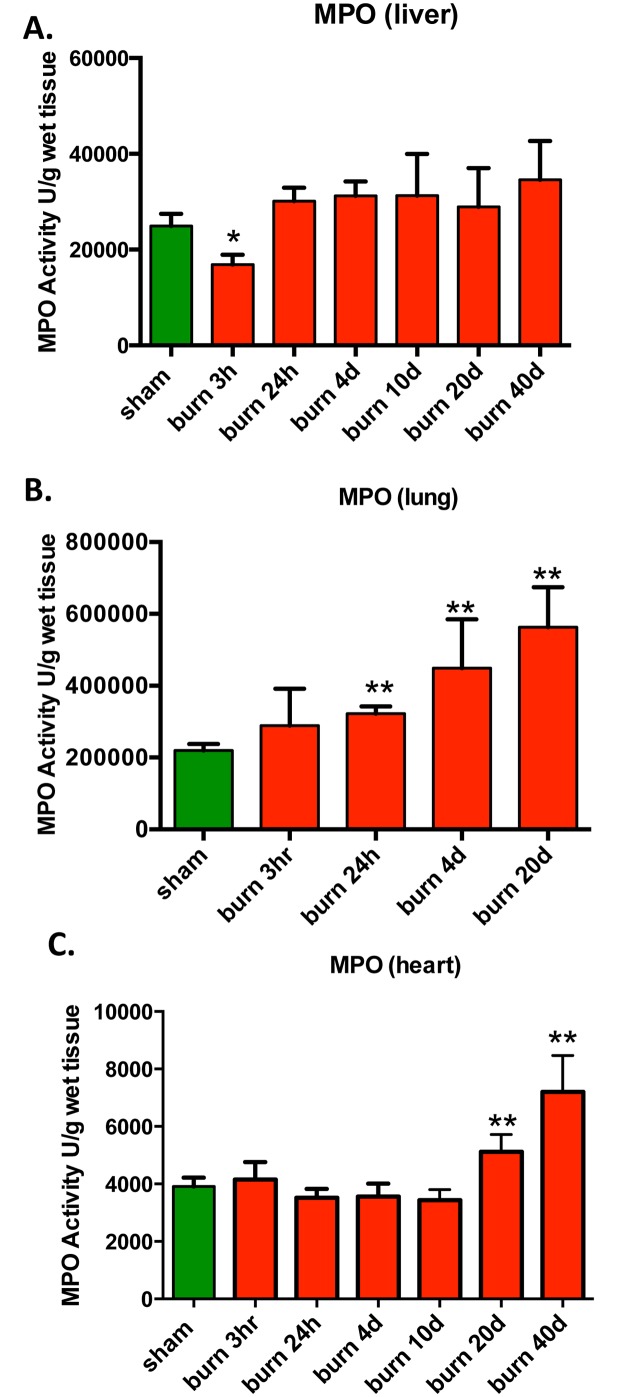
Changes in MPO, an index of mononuclear cell infiltration, in response to burn injury.MPO levels were measured in (A) liver, (B) lungs and (C) heart of mice subjected to burn injury. The results are based on n = 6 per group and represent mean±SD. *, ** p<0.05 and p<0.01 respectively, relatively to sham animals.